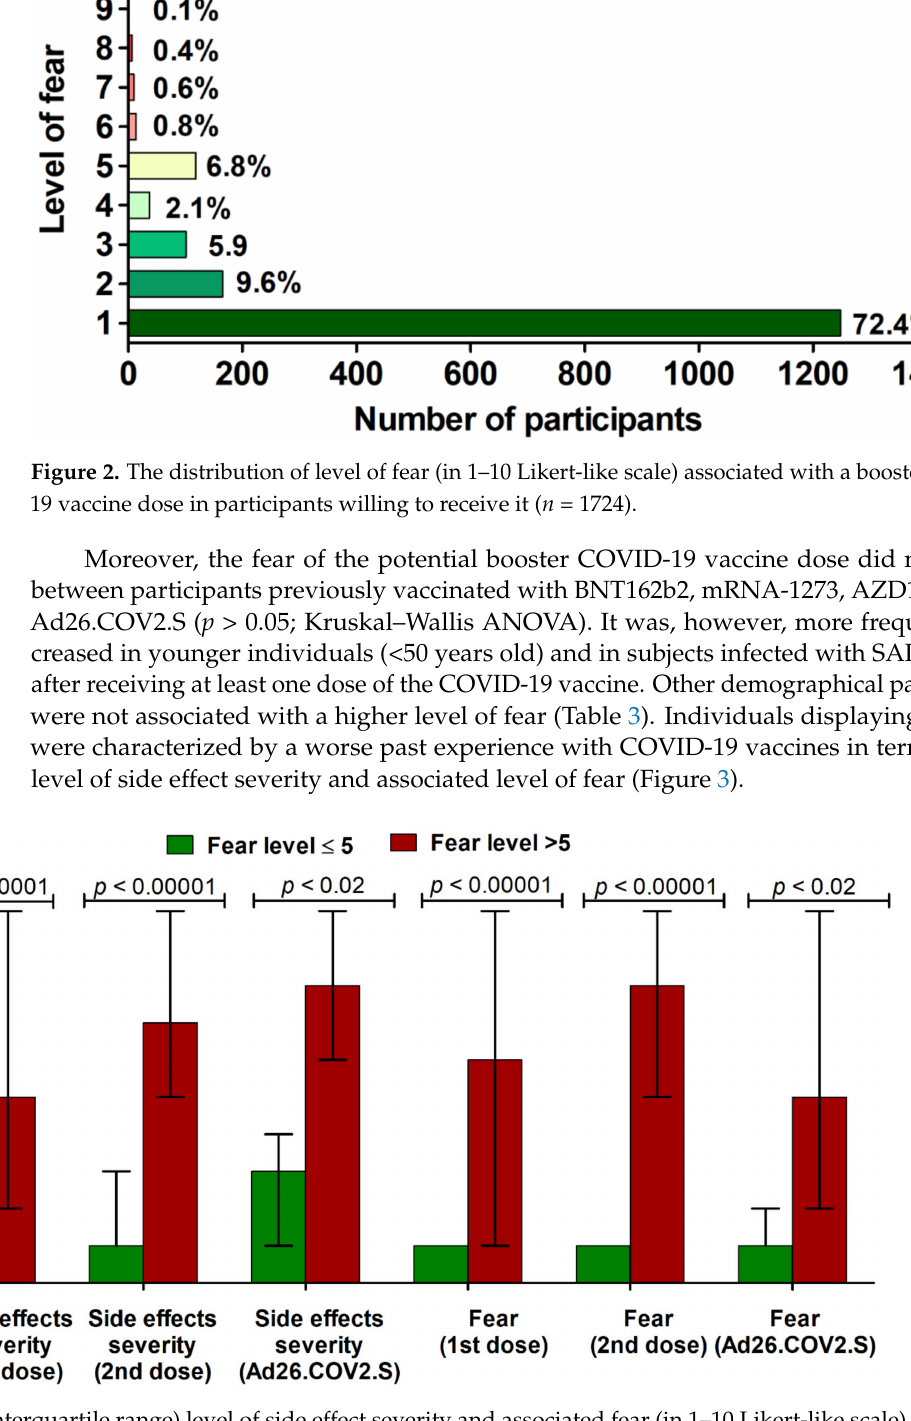
Figure 3. The median (interquartile range) level of side effect severity and associated fear (in 1–10 Likert-like scale) after previously received COVID-19 vaccines in individuals declaring lower (<5) and increased ( ≥ 5) level of fear of the potential booster vaccine dose ( n =